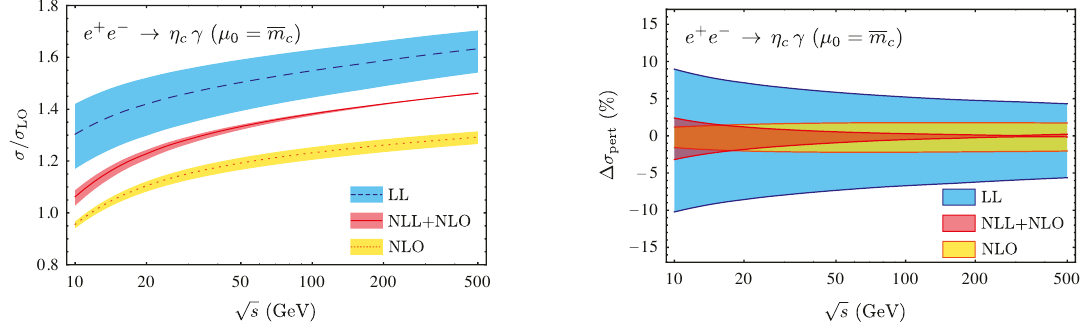
Figure 2 . The same results with (cid:12)gure 1 except for (cid:22) 0 = m c